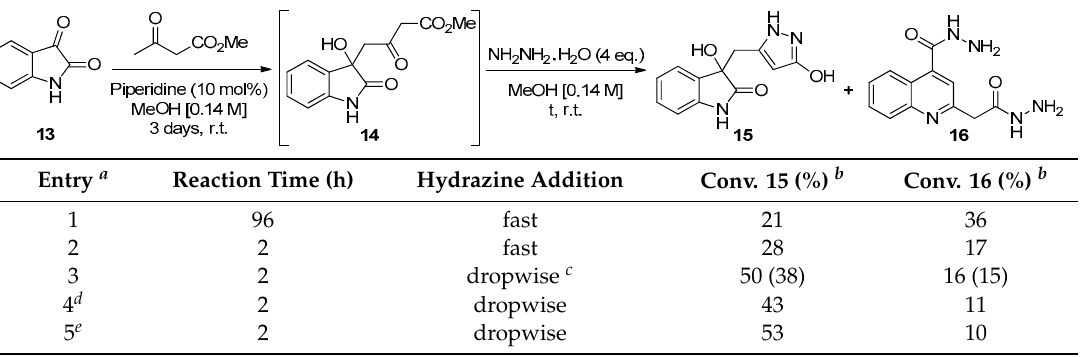
Table 3. Optimisation of the reaction conditions for the preparation of the pyrazole 15 .